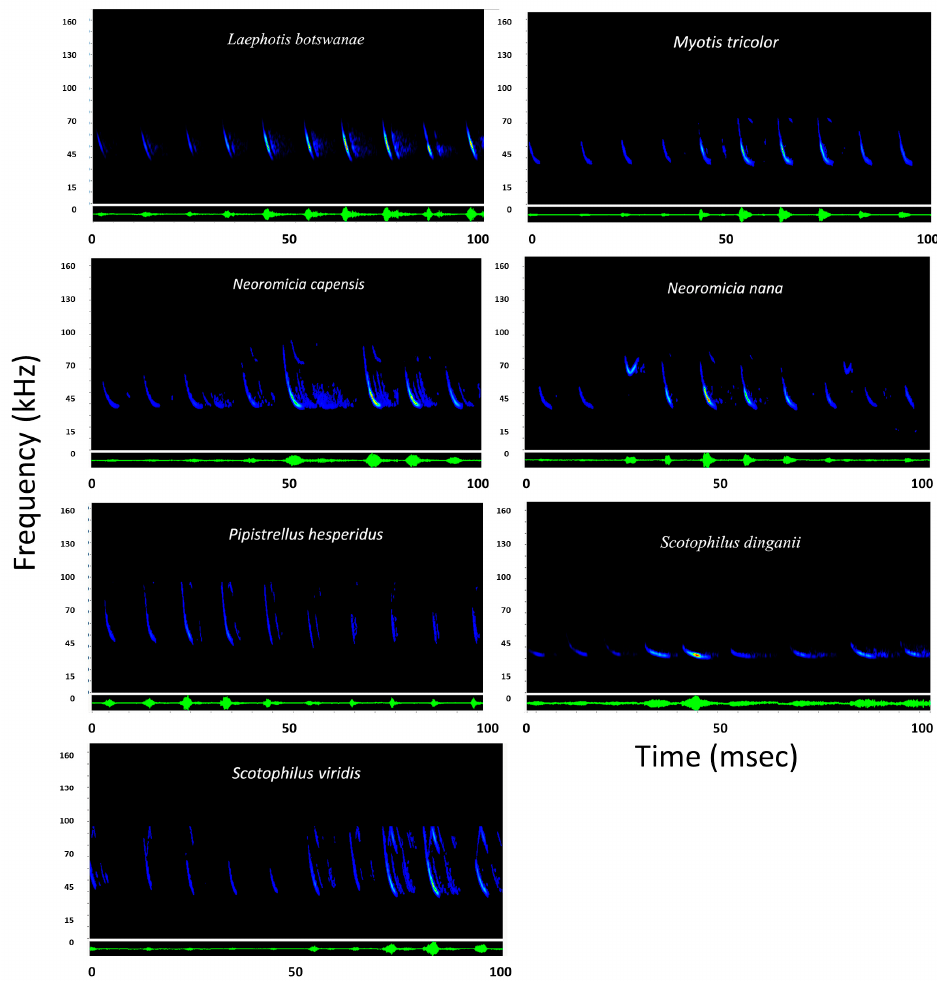
Figure 5. Representative sonogram for bats in the family Vespertilionidae presented using Sonobat 4.1. Y -axis is frequency in kilohertz (kHz) and x -axis is time standardized over 100 milliseconds (msec). Blue coloration indicates lowest sound intensity of the call, yellow indicates medium intensity, and red indicates highest intensity or loudest portion of the call. Green display represents an oscillogram of the call sequence.